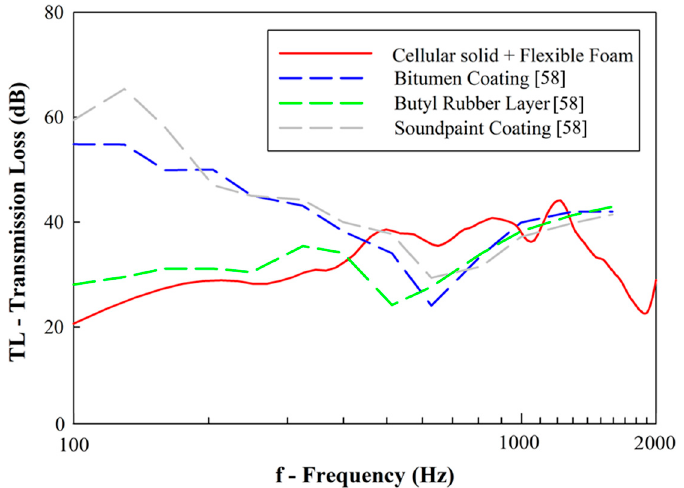
Figure 21. Transmission loss comparison: designed cellular solids vs. other suggested solutions for noise-damping.